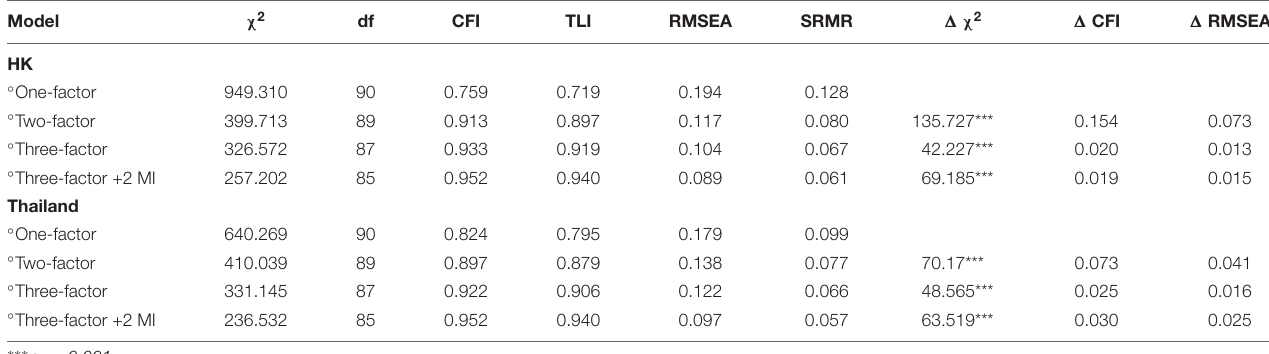
TABLE 1 | Model fit statistics of the three factorial structures for each culture. Model